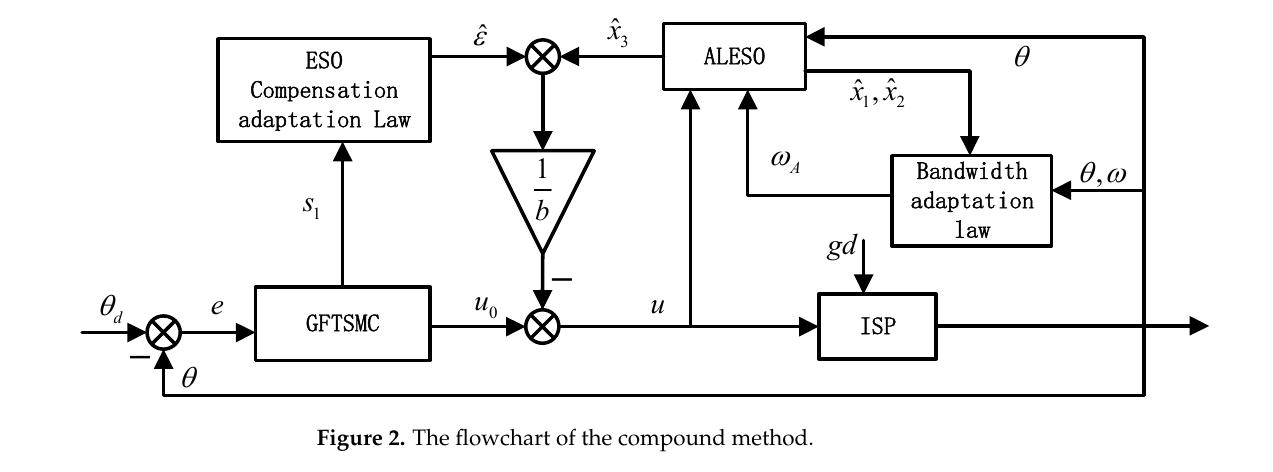
Figure 2. The flowchart of the compound method.